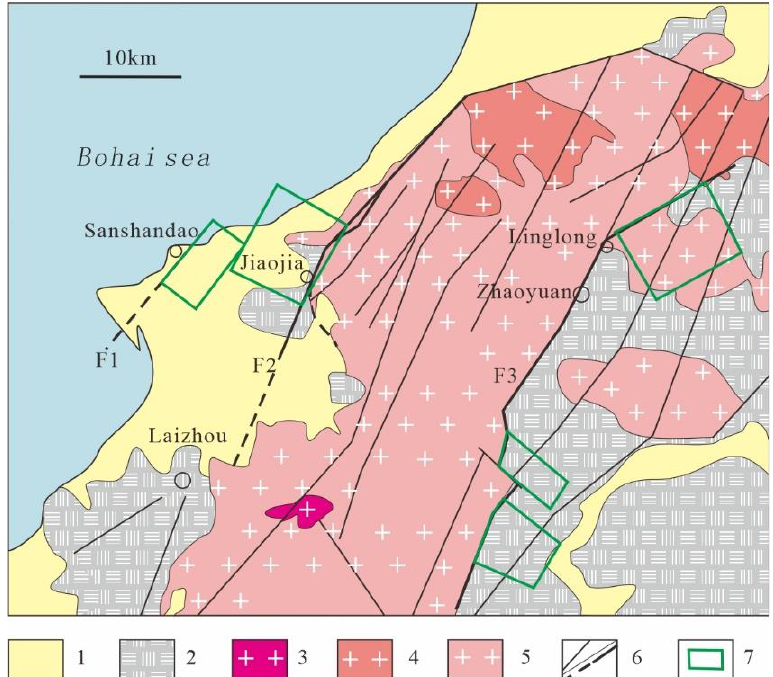
Figure 11. Planar range of the prediction areas of deep resource potential. 1 — Quaternary; 2 — Early Precambrian metamorphic rock; 3 — Cretaceous Weideshan granite; 4 — Cretaceous Guojialing granite; 5 — Jurassic Linglong granite; 6 — Fault; 7 — Range of ore-forming prediction areas.